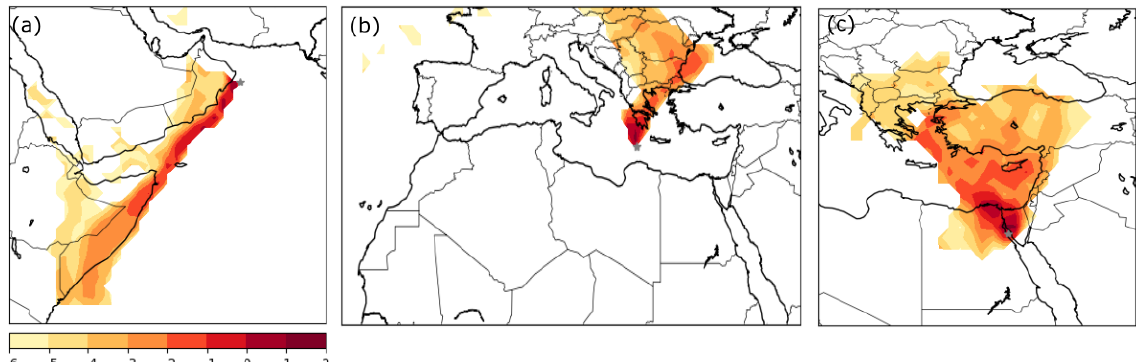
Figure A3. Footprints for ship positions on (a) 8 August 2017 at 06:00UTC, (b) 27 August 2017 at 08:00UTC and (c) 4 July 2017 at 07:00UTC. See the main text for details. Footprints are expressed as log10 of residence time (s) of particles below 2000m. The ship’s position is indicated by the gray